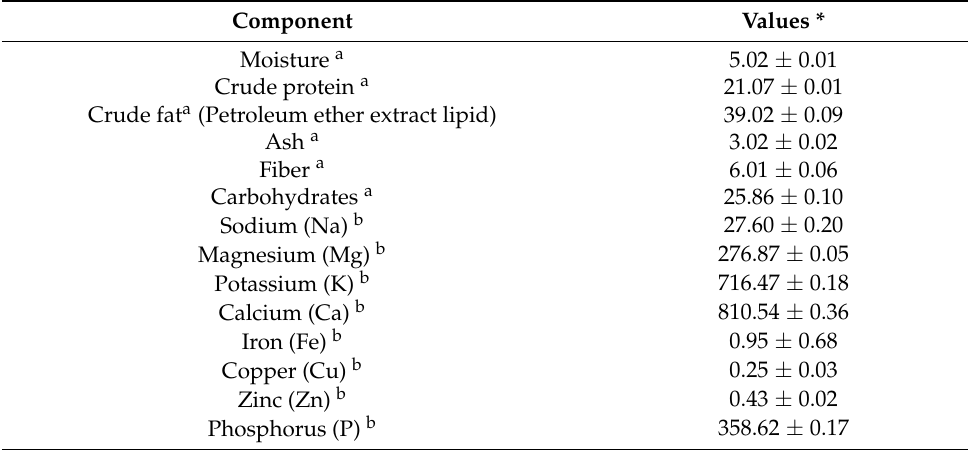
Table 1. Chemical characteristics (dry weight) of black seed ( Nigella sativa